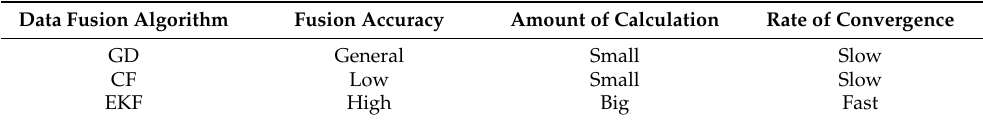
Table 1. Performance comparison of three typical data fusion algorithms